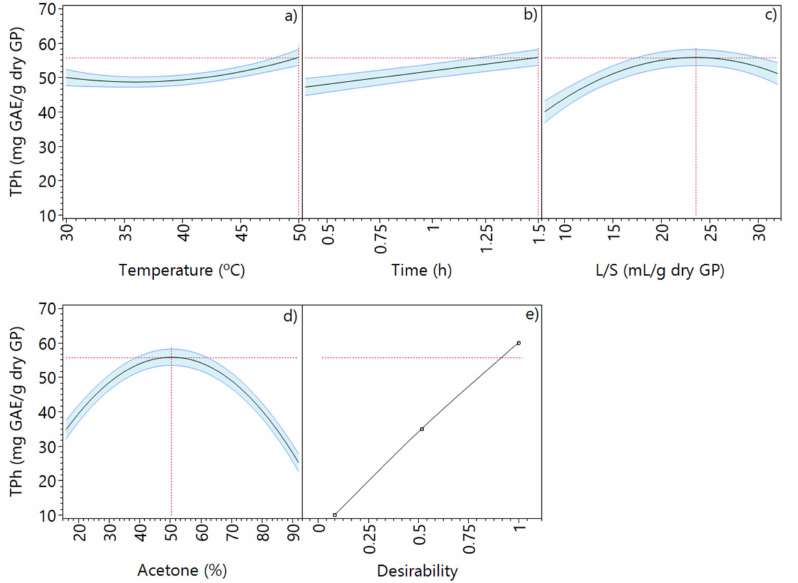
Figure 7. Total phenolic content prediction profiler of acetone extraction at optimized conditions: ( a ) temperature, ( b ) time, ( c ) liquid–solid ratio, ( d ) ethanol concentration, and ( e ) maximized desirability.